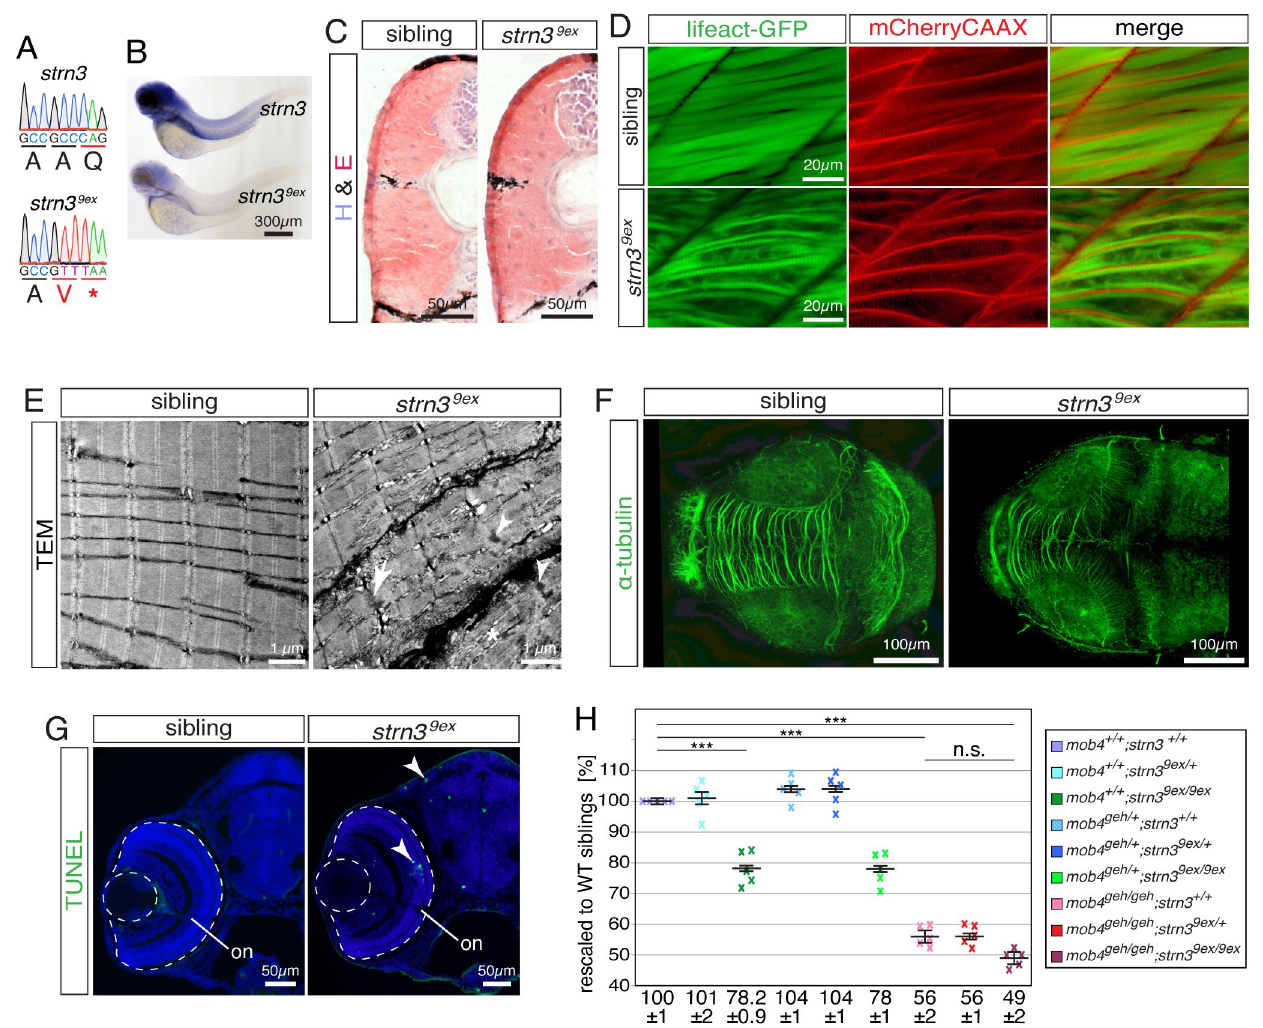
Fig 7. Loss of strn3 phenocopies mob4 -deficient zebrafish. (A) The genomic sequence of the strn3 9ex allele harboured a deletion of 23,516 bp and simultaneous insertion of 35 bp. (B) In comparison to 3-dpf-old siblings, the signal intensity of the in situ hybridisation using a strn3 probe was strikingly diminished in strn3 9ex homozygotes (n = 5 per genotype). (C) Fibrotic signs were not detected on representative cross sections of 3-dpf-old strn3 9ex homozygotes and siblings stained with H&E (n = 6 per genotype). (D) The transgenic marker lines Tg(acta1 : lifeact-GFP) and Tg(acta1 : mCherryCAAX) revealed that the sarcomere striation of live 3-dpf-old siblings was strikingly reduced in strn3 9ex homozygotes, which featured disorganised thin filaments instead (n = 7 per genotype). (E) The sarcomere organisation shown in representative transmission electron micrographs of 3-dpf-old siblings was frequently compromised in strn3 9ex homozygotes. Instead, strn3 9ex homozygotes featured widened Z-disks (arrow), filament deposits (asterisk) and lattice- patterned electron-dense structures (arrowheads) (n = 3 per genotype). (F) Representative Z-stacks of 3-dpf-old larvae stained with antibodies against acetylated α -tubulin. In contrast to their siblings, the intertectal commissure of strn3 9ex homozygotes was strikingly reduced with less neurites projecting across tectal lobes (n = 5 per genotype). (G) Enhanced apoptosis within the retina and tectum of 3-dpf-old representative strn3 9ex homozygotes was confirmed by TUNEL assay (n = 12 per genotype). (H) At 3 dpf, the birefringence of single strn3 9ex homozygotes (78.2 ± 0.9%) and mob4 geh homozygotes (56 ± 2%) as well as strn3 9ex ; mob4 geh compound homozygotes (49 ± 2%) was significantly reduced compared to their WT siblings (100 ± 1%). Importantly however, the birefringence of strn3 9ex ; mob4 geh compound homozygotes was not significantly reduced compared to their single mob4 geh homozygous siblings. Crosses represent averaged birefringence of clutches with a minimum of 4 larvae per genotype (n = 5 clutches). Data are presented as mean ± SEM; ��� P < 0.001 calculated by Student’s t-test. Scale bar sizes are